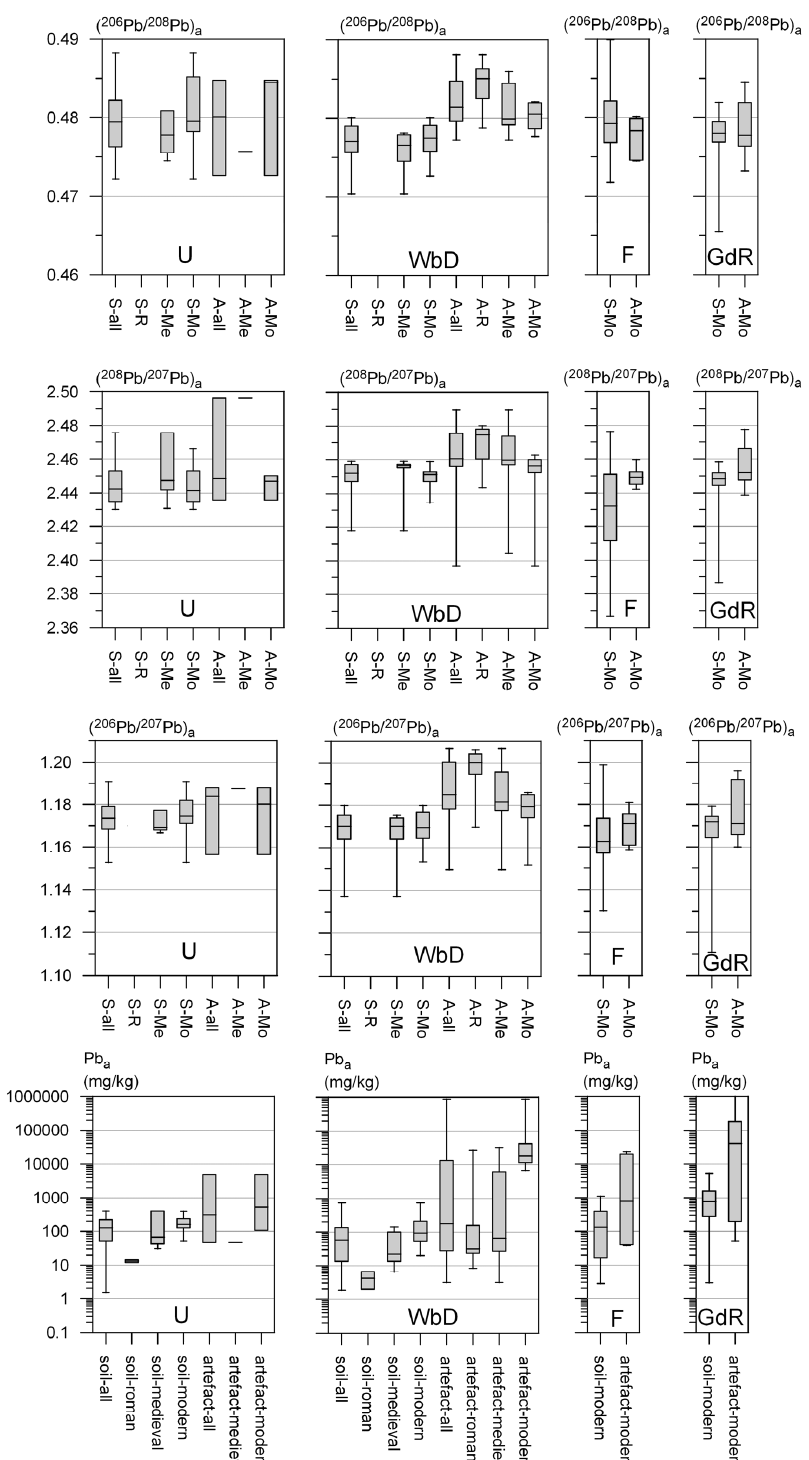
Figure 3. Box-whisker plots of Pb a , ( 206 Pb/ 207 Pb) a , ( 208 Pb/ 207 Pb) a and ( 206 Pb/ 208 Pb) a in the urban soils (S) and potential Pb artefacts (A) showing the minimum (lower whisker), maximum (upper whisker), median (centre of the box), lower quartile (bottom of box), and upper quartile (top of box) values. U = Utrecht; WbD = Wijk bij Duurstede; F = Fijnaart; GdR = Graft-De Rijp.